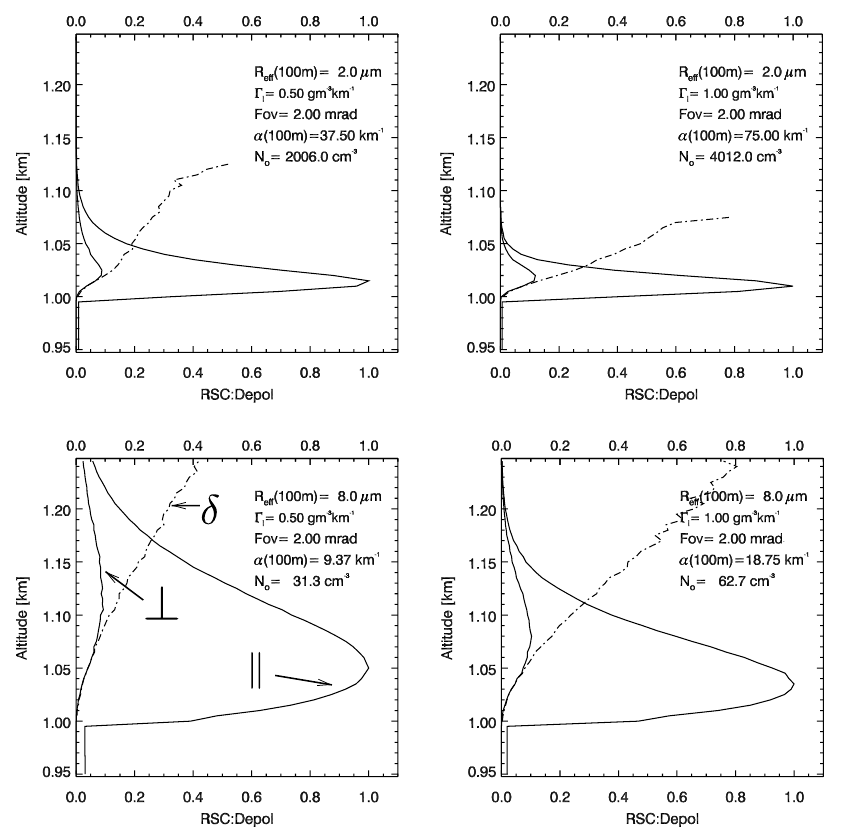
Figure 2. As Fig. 1 except for a lidar FOV of